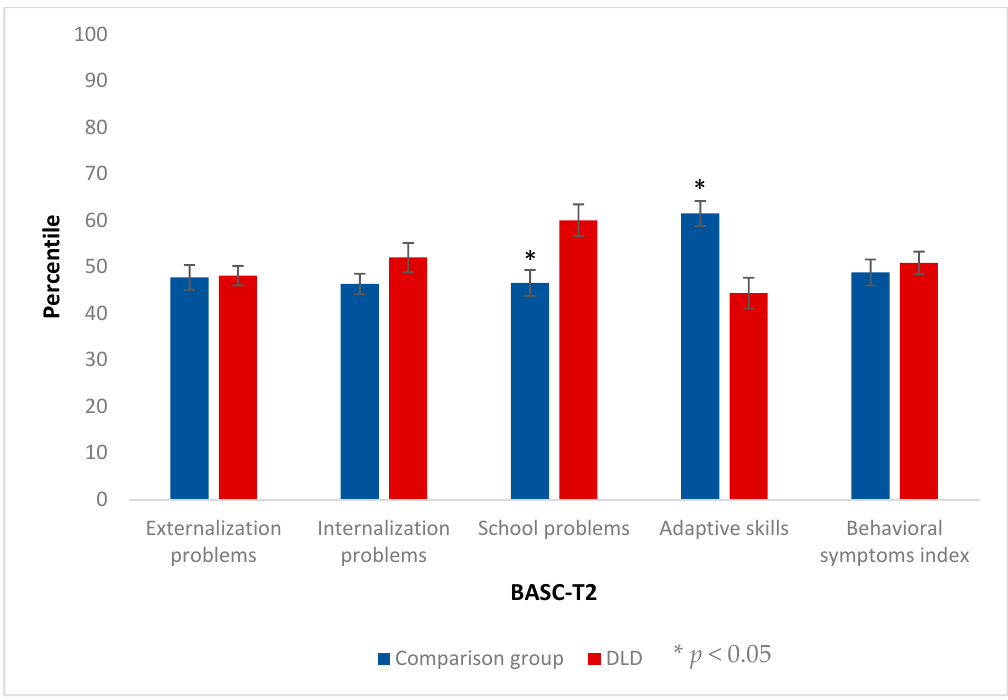
Figure 2. Results for the composite scales of the Behavior Assessment System for Children (BASC) teacher rating scales (T2). The bars represent the means and the error bars represent the standard error. Regarding the participant’s version (S2), only the Emotional Symptoms Index ( U = 53.5, p = 0.041, δ = 0.45) reached significance, with a medium e ff ect size (see Figure 3). The Clinical Maladjustment ( U = 63.5, p = 0.112, δ = 0.35), the School Maladjustment ( U = 82, p = 0.451, δ = 0.16), and the Personal Adjustment ( U = 66, p = 0.140, δ = 0.33) scales did not reveal significant di ff erences between both